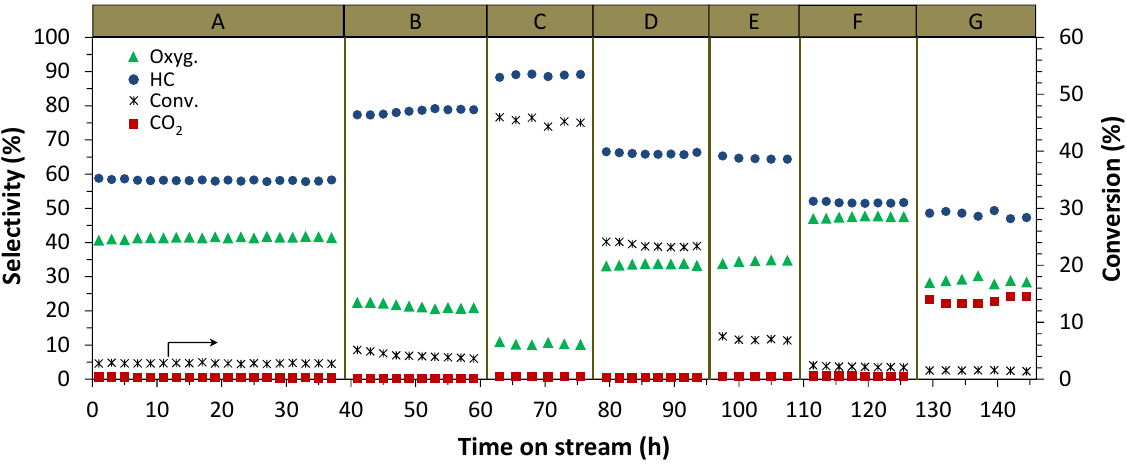
Figure 4. Selectivities and conversion with time on stream for the Rh/SiO 2 catalyst. Oxyg.: alcohols, acetaldehyde, acetic acid and esters. HC: methane and higher